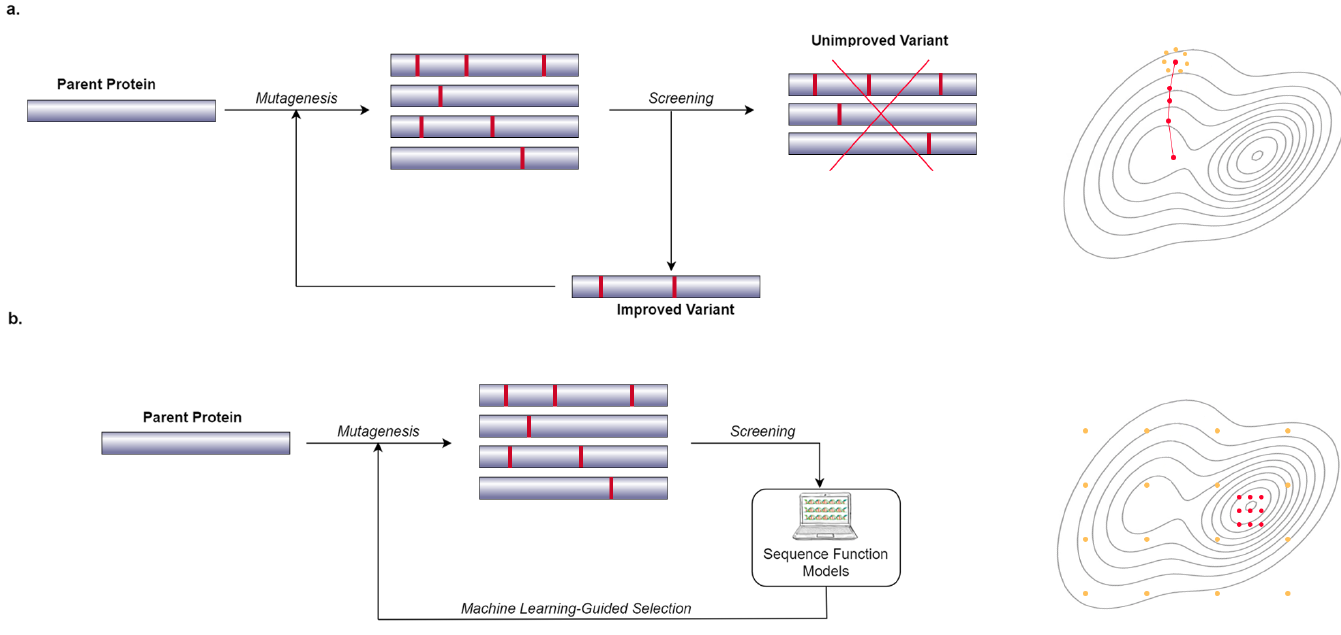
Figure 1 Difference between conventional DE and ML-DE. (A) Conventional DE starts with parent protein undergoing mutagenesis to produce close variants. Detailed lab screening is done to throw out the unimproved variants and select the improved ones for the next generation of the mutagenesis. This process continues until a desirable mutant is found. (B) Commonly in ML-DE, sequence-function models replace the rigorous screening and selection task in conventional DE. ML-DE is able to explore more of the search space in the same amount of time and has a lower risk to get stuck in a local optimum. In (B) any of the orange dots can be rationally chosen as the start of the optimization, while in (A) the search space is limited to the direction of the search. Full-size DOI: